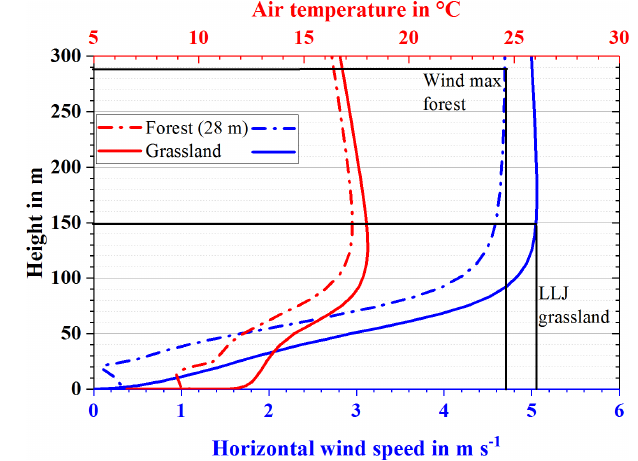
Figure 5. Height and maximum wind speed of nocturnal LLJ events dependent on type of vegetation: grassland (black), decid- uous (green) and coniferous (red) forest, for vg = 4ms − 1 . Dotted blue lines mark the range of LLJ wind speed